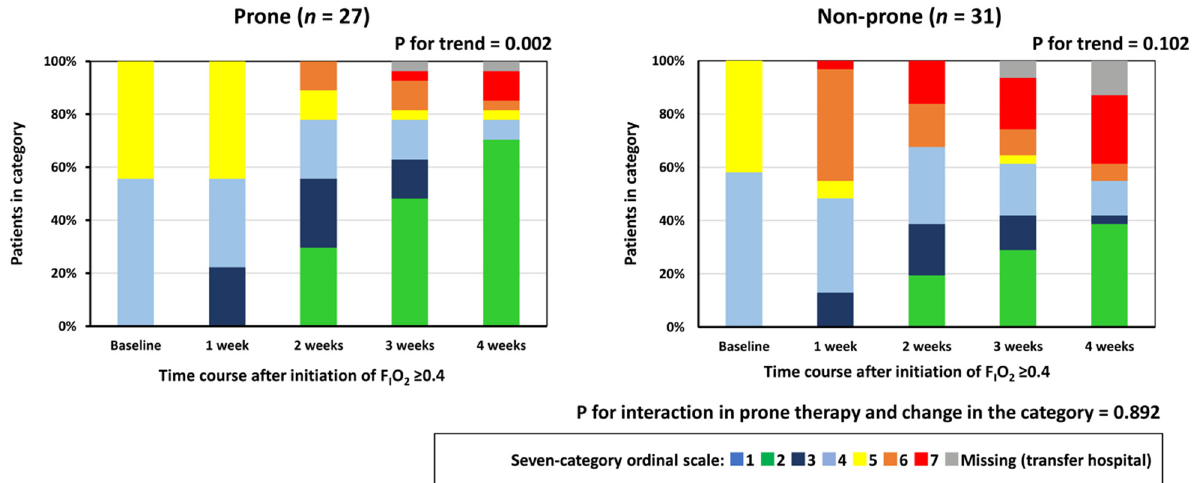
Figure 3. Seven-category ordinal scale after initiation of F I O 2 ≥ 0.4 between the two groups based on prone therapy. The seven-category ordinal scale consisted of the following categories: 1, not hospital- ized with resumption of normal activities; 2, not hospitalized, but unable to resume normal activities; 3, hospitalized, not requiring supplemental oxygen; 4, hospitalized, requiring supplemental oxygen; 5, hospitalized, requiring nasal high-flow oxygen therapy, non-invasive mechanical ventilation, or both; 6, hospitalized, requiring ECMO, invasive mechanical ventilation, or both; and 7, death. Data indicate proportion of patients in each category. F I O 2 , fraction of inspired oxygen.